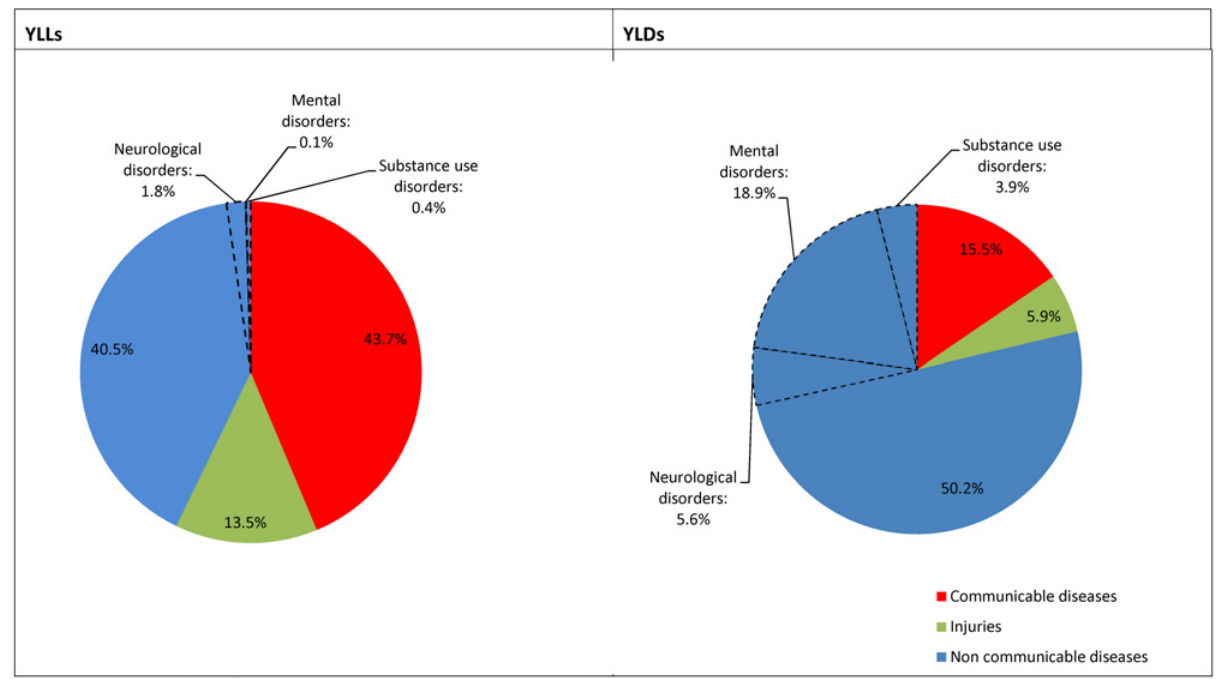
Fig 4. Proportion of Global YLDs and YLLs Attributable to Mental, Neurological, and Substance Use Disorders,